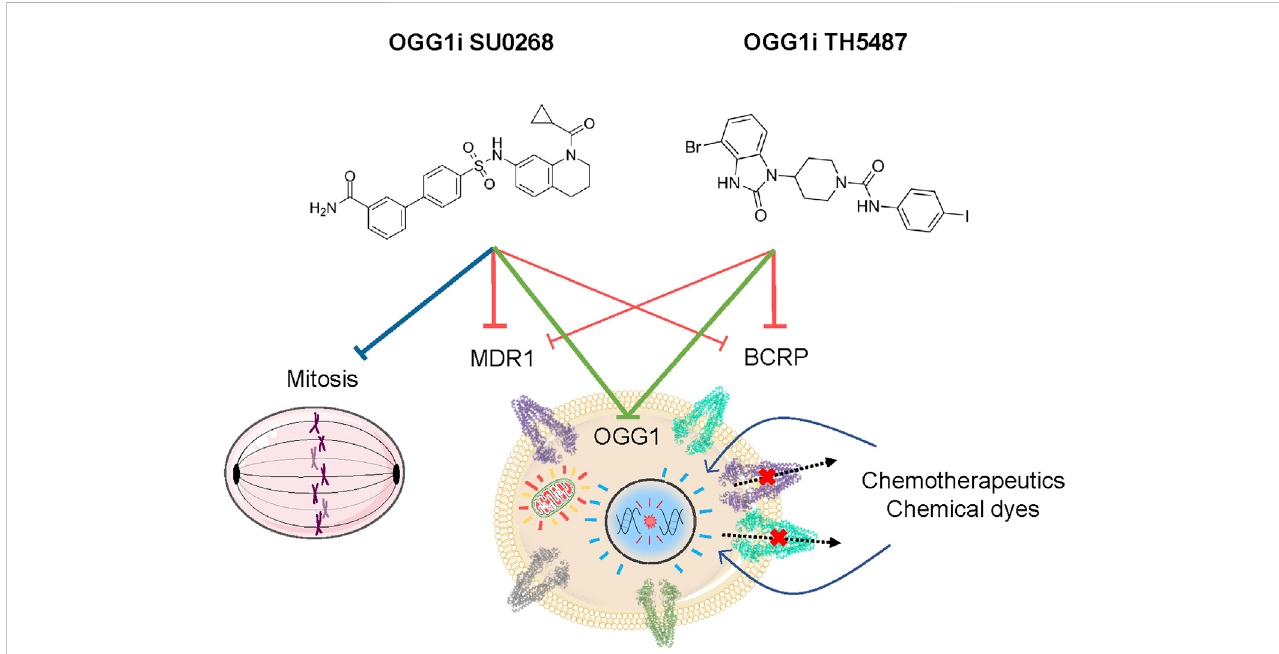
FIGURE 5 Cellular effects of the OGG1 inhibitors TH5487 and SU0268. Beside their activity as inhibitors of the DNA glycosylase activity of OGG1, TH5487 and SU0268 have several off-target effects that are independent on OGG1. Both molecules inhibit the activity of the ef fl ux pumps MDR1 and BCRP1, thus increasing the intracellular concentration of fl uorescent dyes and chemotherapeutical molecules. In addition, SU0268 impairs mitotic